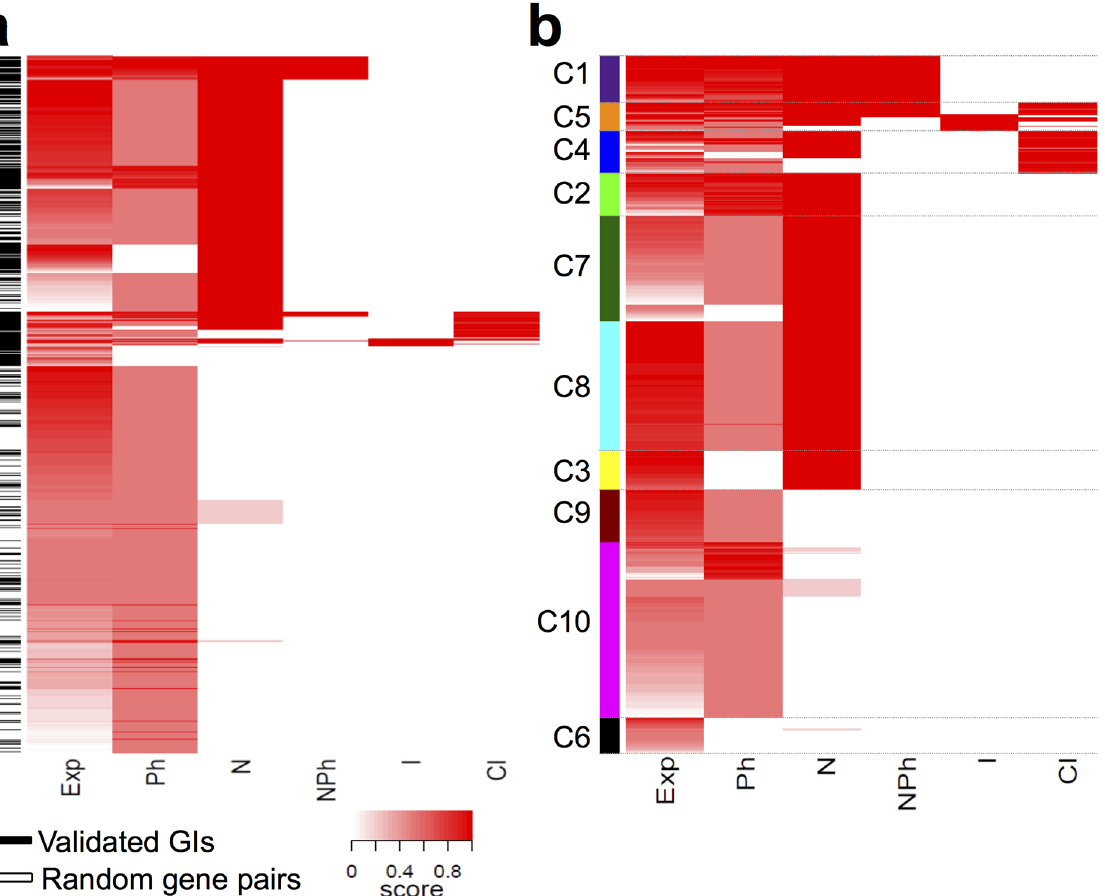
Fig 1. Identifying GI classes. (a) Positive (GIs, black lines) and negative (Random gene pairs, white lines) examples of genetic interactions were clustered based on their attribute scores using unsupervised methods. Columns show values for the six attributes used to predict interactions in [54]. Each individual attribute is either a measure of genes co-expression levels ( Exp ) or enrichment of shared phenotypes ( Ph ). They are also indicator for whether the neighborhoods of the genes of interest are enriched with the same phenotype ( N ). Here we define the neighborhood of a given gene as the set of genes that show significant co-expression with it ( P (cid:1) 0.05, see Methods) and/or encode proteins that exhibit a PPI with the product of this gene. NPh is an indicator like N with the additional requirement that the genes of interest themselves must also exhibit the phenotype enriched in their neighborhoods. Attributes I and CI indicate that interacting genes code for interacting proteins or for proteins sharing a significantly high number of common protein-protein interaction partners. Scores correspond to the following valuation: 1 or 0 (on a binary system) for N , NPh and I attributes. (1 – ( P -value < 0.05)) for Exp , Ph and CI attributes. (b) Positive examples of genetic interactions were clustered and identified by the color code on the